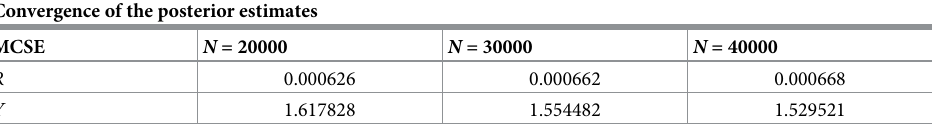
(Algorithm 5) [35] for inferring the latent intensity λ N ( t ) and the reproduction number R ( t ) illustrated in a new simulation scenario C (see Fig 5). Scenario C concerns a process triggered by 661 infectious and generated similar to scenario A assuming that α = 0.5, b = 2, d = 15.11, = 10, d = 20, v = 0.0001 and v = 0.5. The time-constant v = 0.01, R 1 = 1.57, d min max min max parameters d and v are known for BF and APF. We used 10000 iterations of the PMMH sam- pler with a burn-in of 5000 iterations. We use APF using 50 particles as an SMC sampler. The Table 1. MCSEs of posterior means of weights and weekly hidden cases in Scenario A.